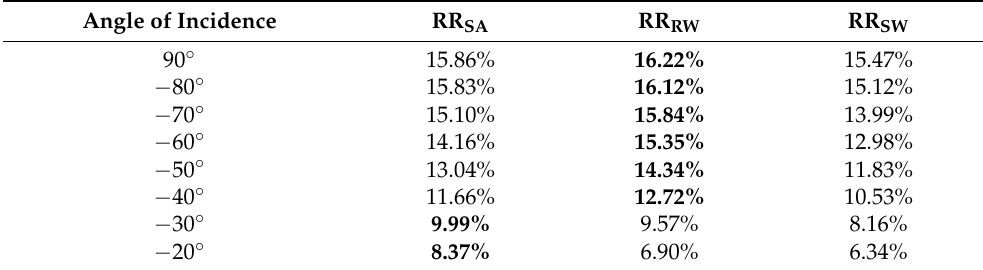
Table 3. Retro-reflectivity of the three RR samples, for each angle of incident radiation. Percentage values are referred to the ratio between the radiation reflected back to the source and the total reflected radiation for each sample. The RR sample with the maximum retro-reflective percentage is highlighted in bold for each angle of